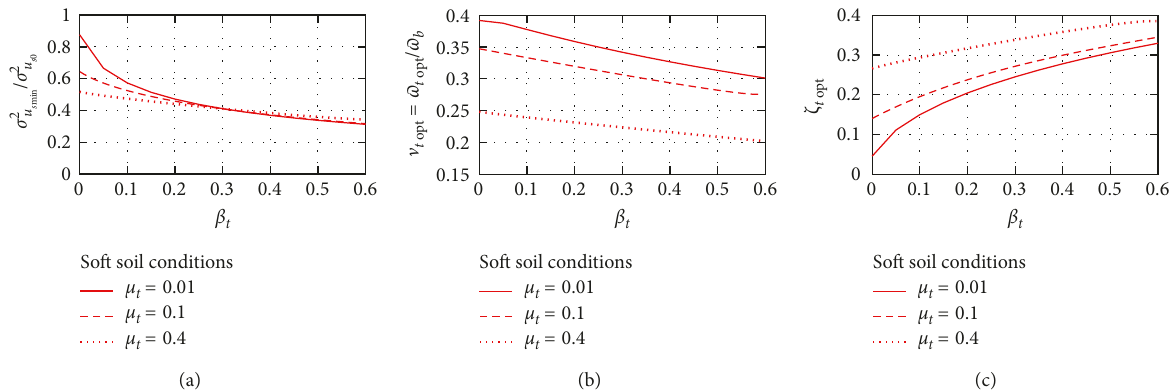
Figure 8: Optimal TMDI tuning for soft soil conditions: (a) minimum OF achieved, normalized with respect to the case without TMDI; (b) optimal frequency ratio; (c) optimal damping ratio.